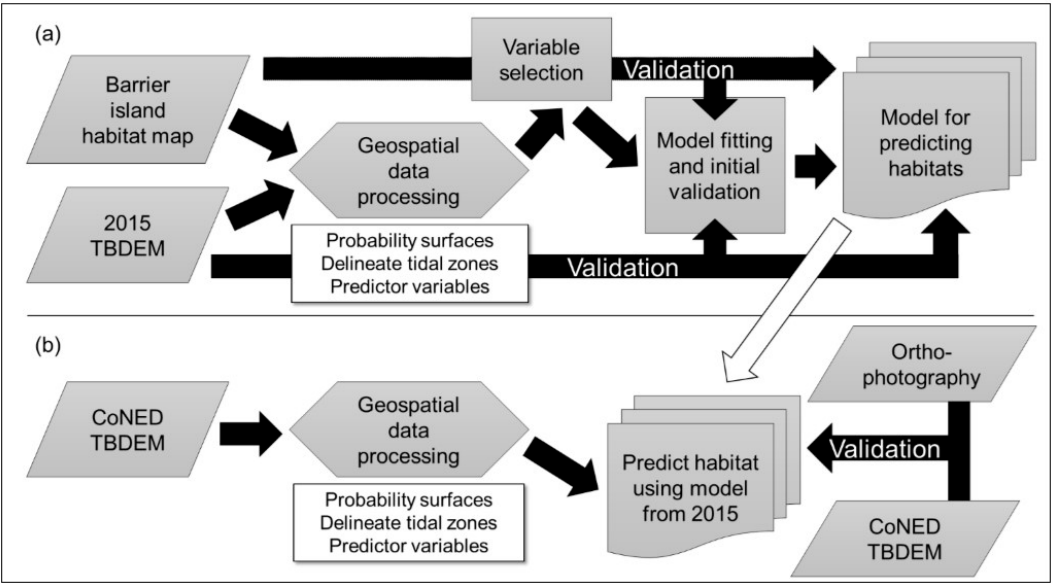
Figure 5. Workflow for the barrier island habitat model development for Dauphin Island, Alabama, USA. ( a ) Overview of process for developing and validating the contemporary model for predicting barrier island habitats using a habitat map and a topobathymetric (TBDEM) from 2015; ( b ) Overview of the process for predicting barrier island habitats using historical data from the USGS Coastal National Elevation Dataset (CoNED) TBDEM using the model fitted with contemporary data (i.e., hindcast).